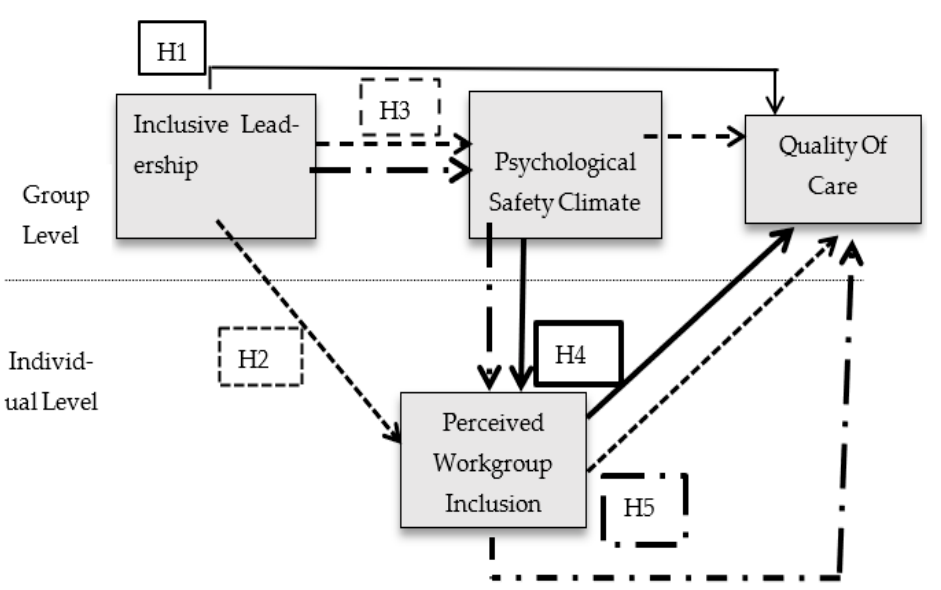
Figure 1. Multilevel hypothesized model. The dashed lines in Figure 1 separate the group-level variables (i.e., that is, inclusive leadership, psychological safety climate, and quality of care) and individual-level variables (i.e., perceived workgroup inclusion).